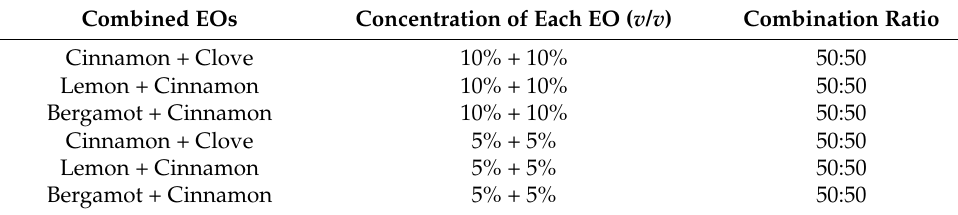
Table 1. Binary combinations of EOs with different concentrations and ratios. Combined EOs Concentration of Each EO ( v / v